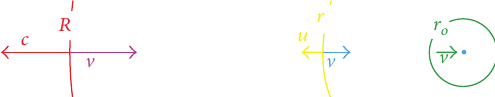
Figure 2: Schematic view angle of the Universe opens from a blue dot (at right) that signifies the Earth. Particles that arrive to our detectors with velocity V have departed either with the same velocity (green arrow) from sources in the nearby nonexpanding sphere of the Universe within a radius 𝑟 𝑜 (green circle) or with a higher velocity (blue arrow) from sources that are receding with velocity 𝑢 as exemplified to reside at a distance 𝑟 (yellow arc). No particle with velocity V < 𝑐 will attain our observatories from the perimeter of the Universe at 𝑅 (red arc) that is expanding with the speed of light 𝑐 .